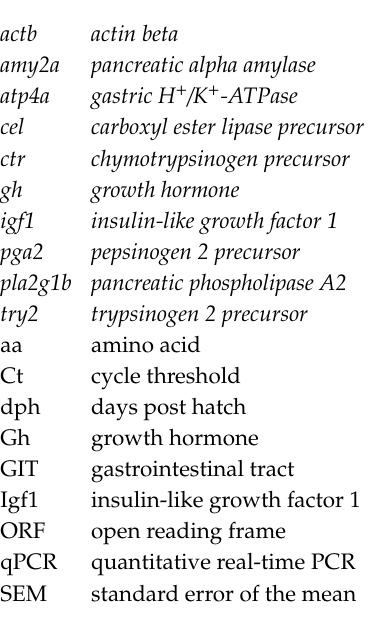
Figure S1: Nucleotide and amino acid sequences for C. labrosus carboxyl ester lipase, Figure S2: Nucleotide and amino acid sequences for C. labrosus pancreatic phospholipase A2, Figure S3: Nucleotide and amino acid sequences for C. labrosus gastric proton pump, Figure S4: Nucleotide and amino acid sequences for C. labrosus β -actin, Figure S5: Comparison of cycle threshold (Ct) average values of the calibrator sample for all the studied genes, Table S1: Nutritional value of the commercial feeds used in the intensive culture of C. labrosus , Table S2: Sampling points of C. labrosus in relation to ontogenic events, according to the key ontogenic events defined by histochemistry approaches [10], Table S3: Oligonucleotides used for cloning C. labrosus cDNA sequences, Table S4: Teleost species and GenBank accession numbers of cDNA sequences used to design degenerate primers., Table S5: Top five blast hits for the cloned cDNAs and their putative amino acid translations from C. labrosus